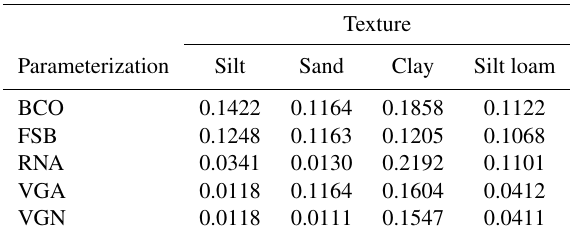
Figure 3. Observed and fitted retention curves for the different soil textures. Table 2. Root mean square errors (RMSEs) for the different param-